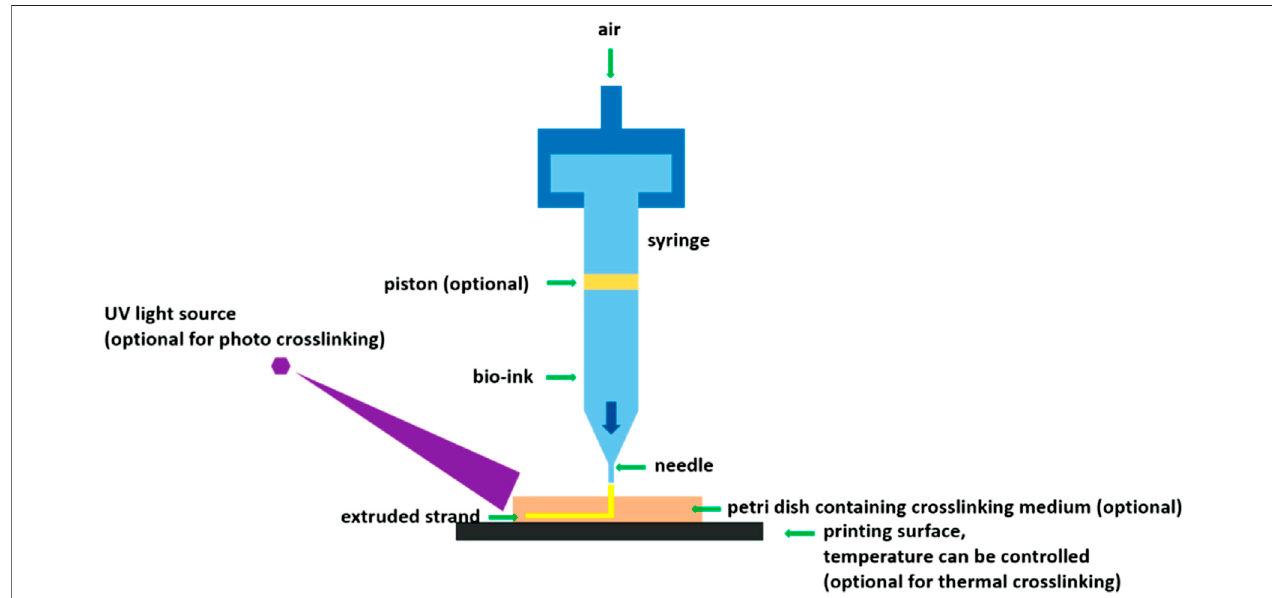
FIGURE 2 | Extrusion-based 3D printing schematic. (Schematic of extrusion-based bioprinting using various crosslinking mechanisms (You et al., 2017). Reproduced from (You et al., 2017) with permission from Copyright 2021 MDPI).